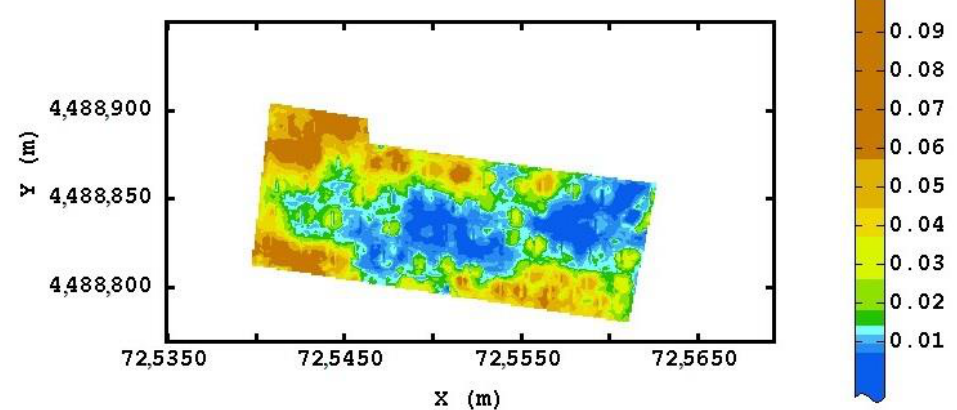
Figure 12. The SIDSAM map. Colour scale uses isofrequency classes. The position of the reference spectrum is indicated (red circle).